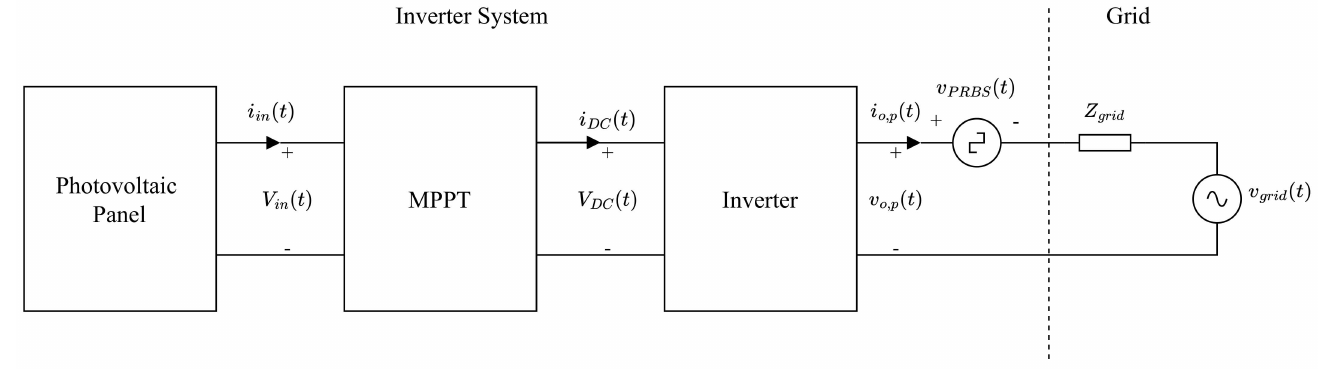
Figure 18. Block diagram of the inverter system during PRBS